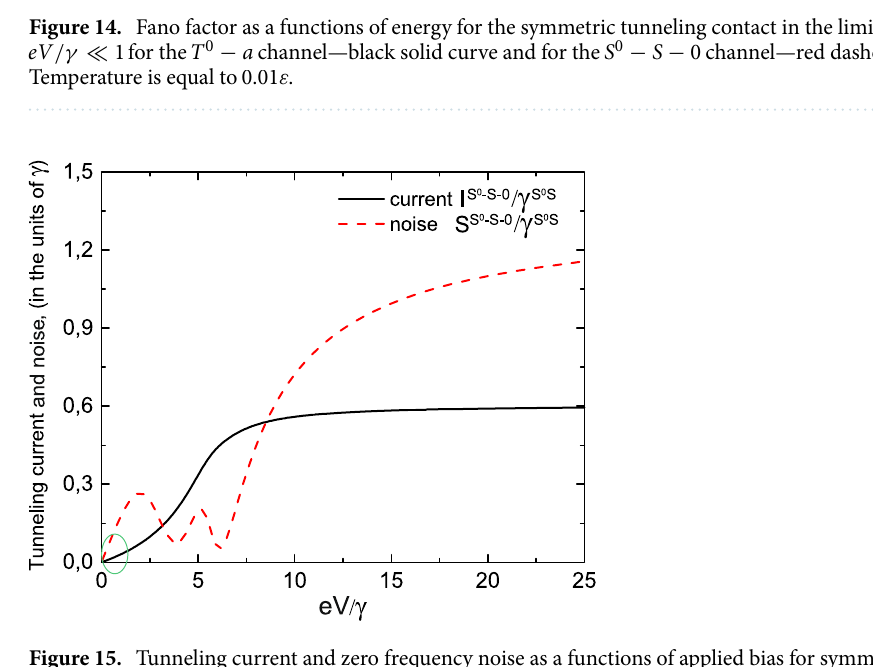
Figure 15. Tunneling current and zero frequency noise as a functions of applied bias for symmetric tunneling 0 channel. Tunneling current is shown by the solid black line 1 for the S 0 S contact in the limit ε/γ − − ≫ and zero frequency noise is depicted by the red dashed curve. Green circle shows the system parameters where Landauer–Büttiker formalism can be applied. Temperature is equal to 0.01 ε